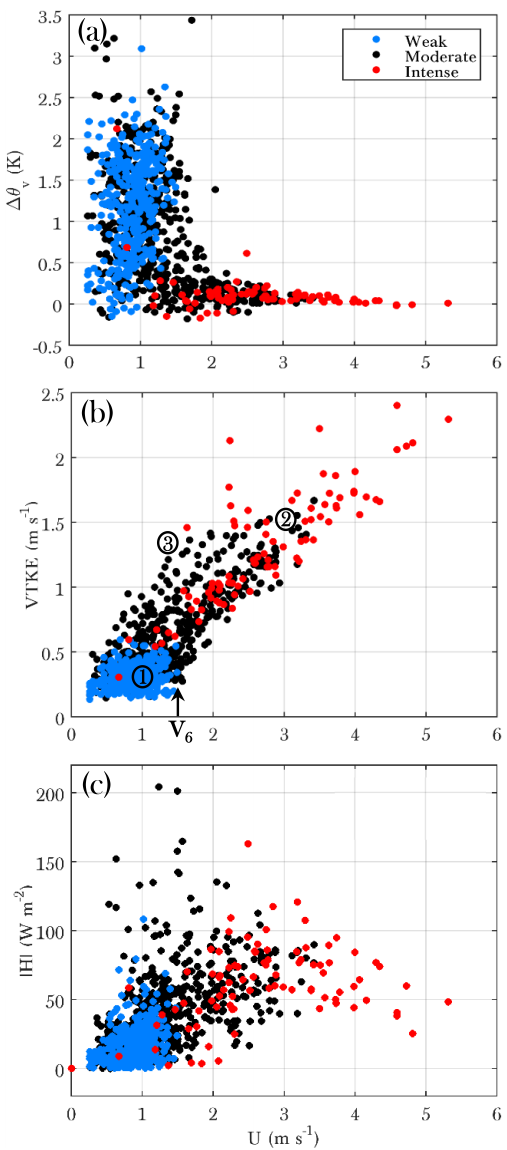
Figure 6. (a) Thermal stratification ( (cid:49)θ v = θ v ( 10m ) − θ v ( 3m ) ) , (b) turbulence velocity scale ( V TKE ) and (c) the absolute value of the sensible heat flux ( H ) at 8m vs. wind speed ( U ) at 6m. The numbers in panel (b) pinpoint the SBL regimes defined in Sun et al. (2012): (1) weak turbulence driven by local instabilities, (2) intense turbulence driven by the bulk shear and (3) moderate turbulence driven by top-down events. The threshold wind speed ( V 6 ) at which the HOST transition occurs is indicated